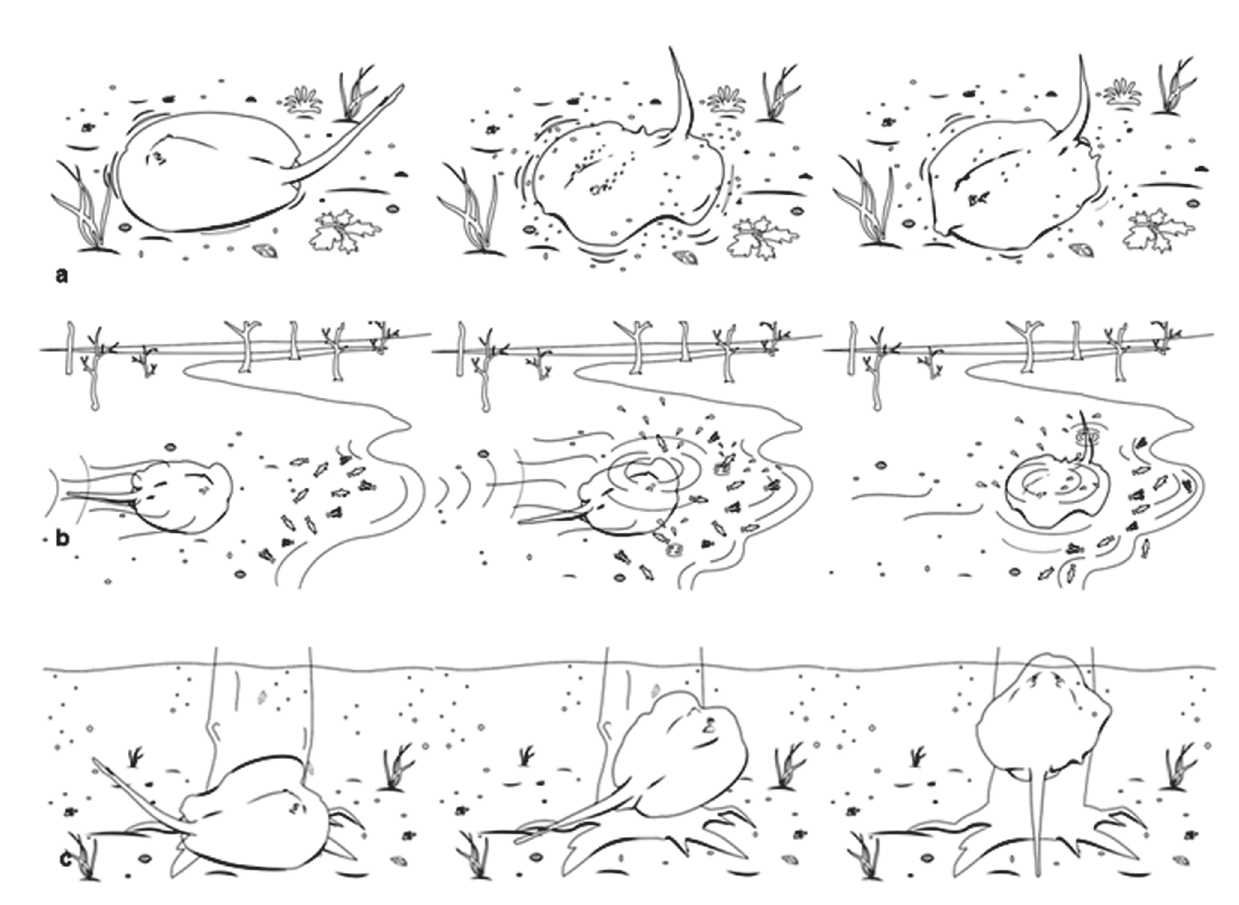
Fig. 2. Hunting tactics of Potamotrygon falkneri and Potamotrygon motoro at the Paraná River. Settling close to the bottom, undulating the disc to stir the substrate, and engulfing uncovered prey trapped under the disc (a); approaching the shallows, charging towards concentrated preys, and engulfing prey trapped under the disc (b); approaching a submerged tree stump, ascending towards surface, and exposing anterior part of the disc to pick snails adhered slightly above water surface